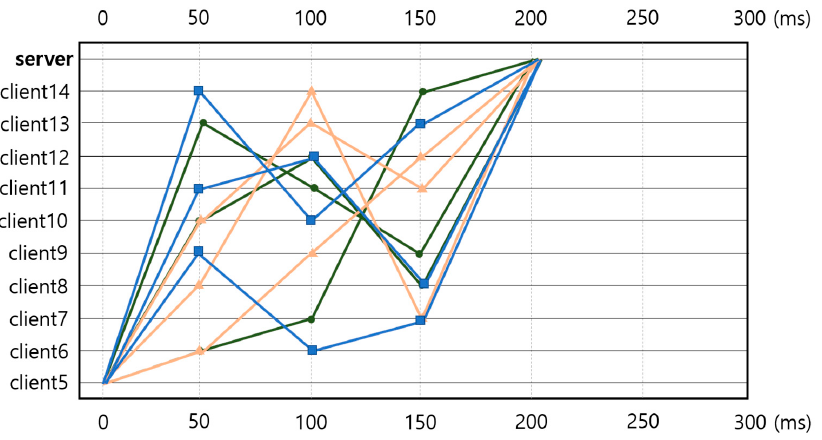
Figure 14. Transmission speeds from the clients to the server.